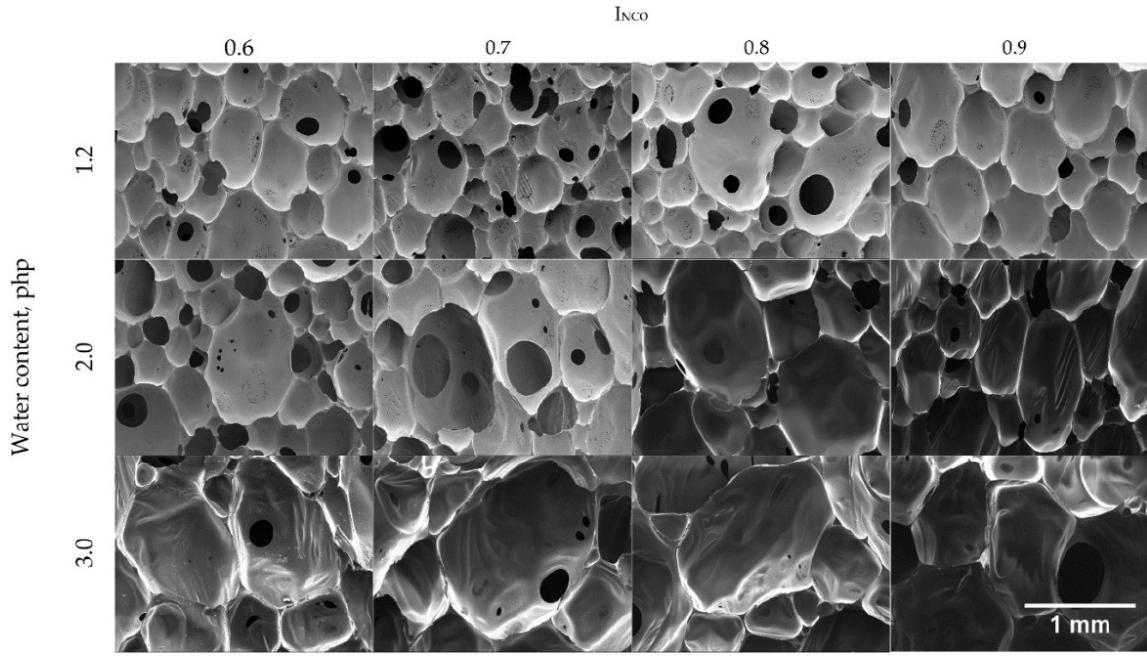
Figure 3. SEM images of foams depending on water content and isocyanate index. Table 4. Structural parameters of foams depending on the isocyanate index and water content. Foam Type Mean Pore Equivalent Diameter, d 2 , µ m Pore Aspect Ratio AR,